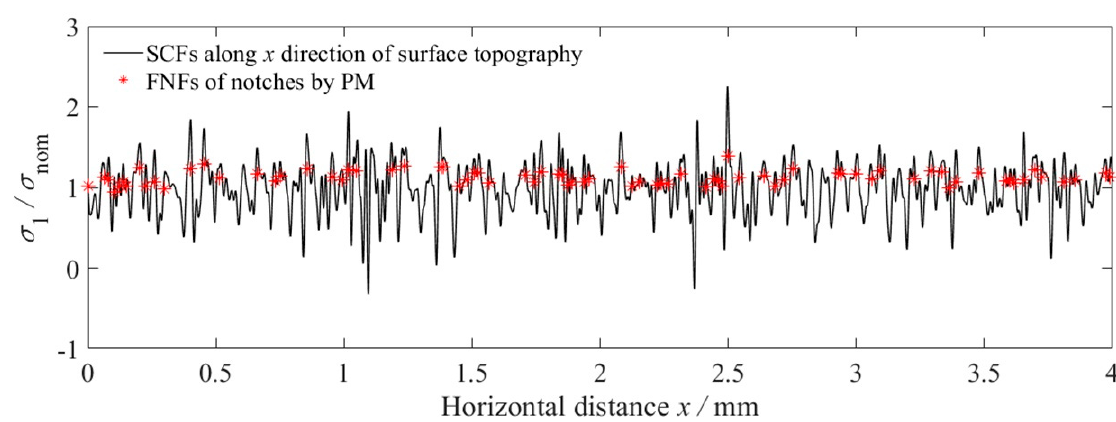
Figure 7. Machined surface topography and simulated surface topography for specimen B1.